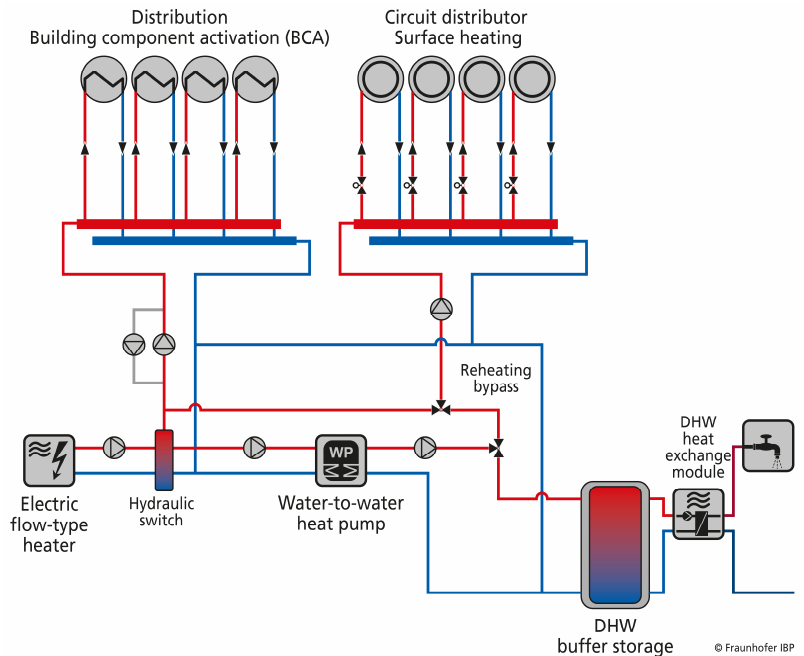
Figure 2. Sketch of the TABS storage to supply a building with space heating and domestic hot